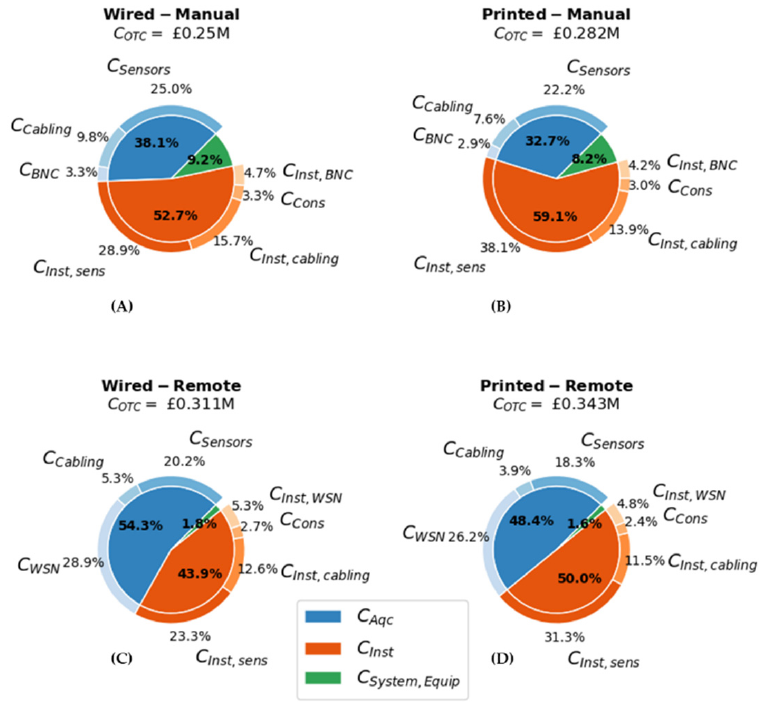
Figure 7. Breakdown of the acquisition (cid:3435)𝐶 (cid:3002)(cid:3044)(cid:3030) (cid:3439) , installation (𝐶 (cid:3010)(cid:3041)(cid:3046)(cid:3047) ), and system equipment (cid:16) (cid:17) C System , Equip costs for the ( A ) Wired–Manual, ( B ) Printed–Manual, ( C ) Wired–Remote and ( D ) Printed–Remote SHM system configurations.